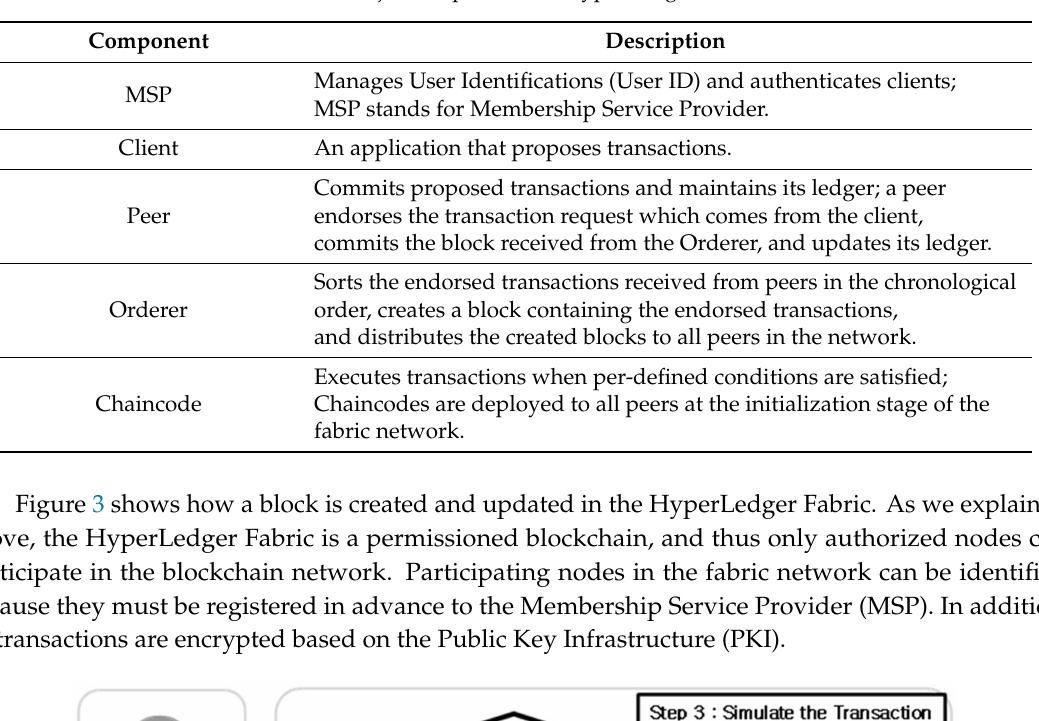
Table 1. Major components of HyperLedger Fabric.